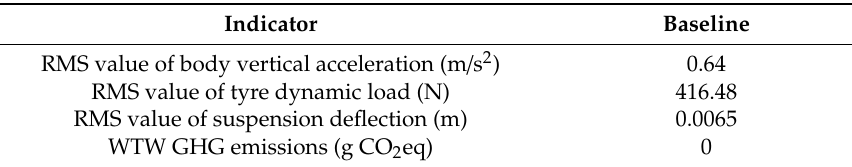
Table 3. The baseline of performance